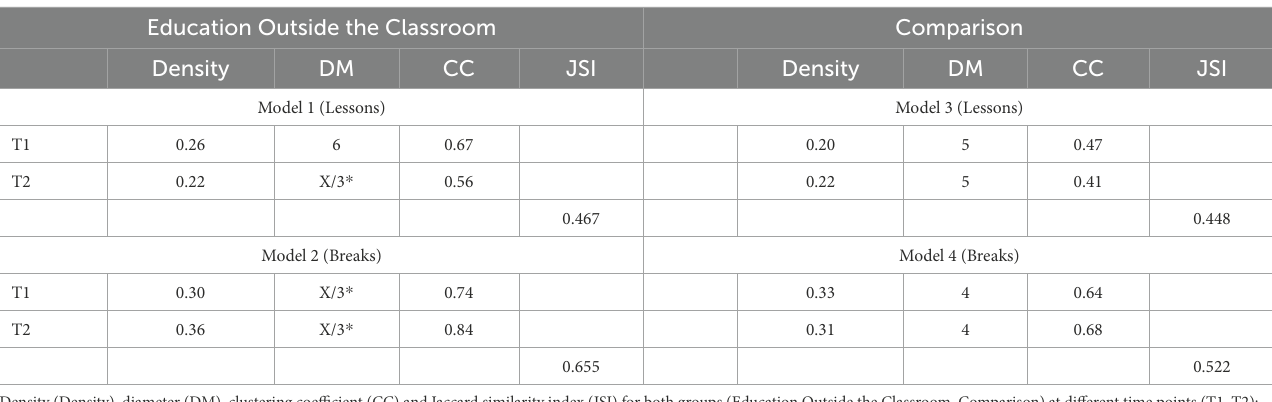
TABLE 3 Network parameters.